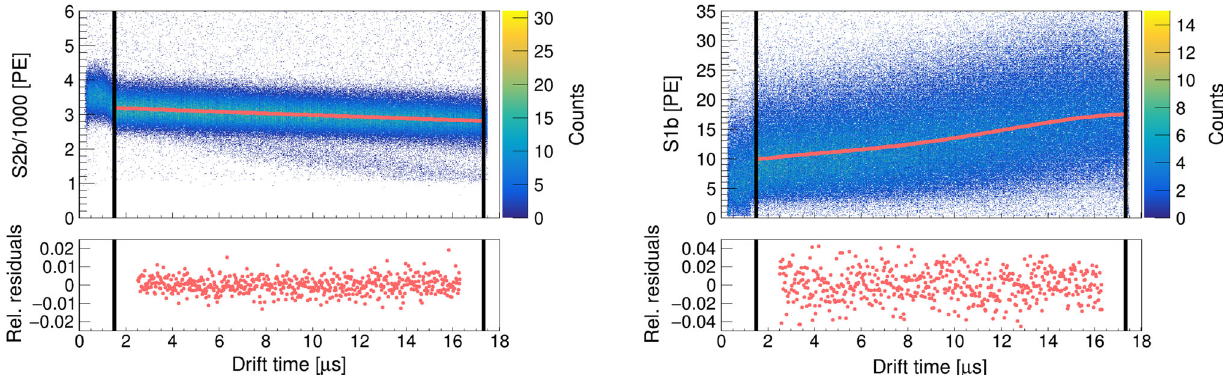
Fig. 7 Corrections for systematic detector effects. The drift region defined by the cathode and the gate is marked by solid black lines